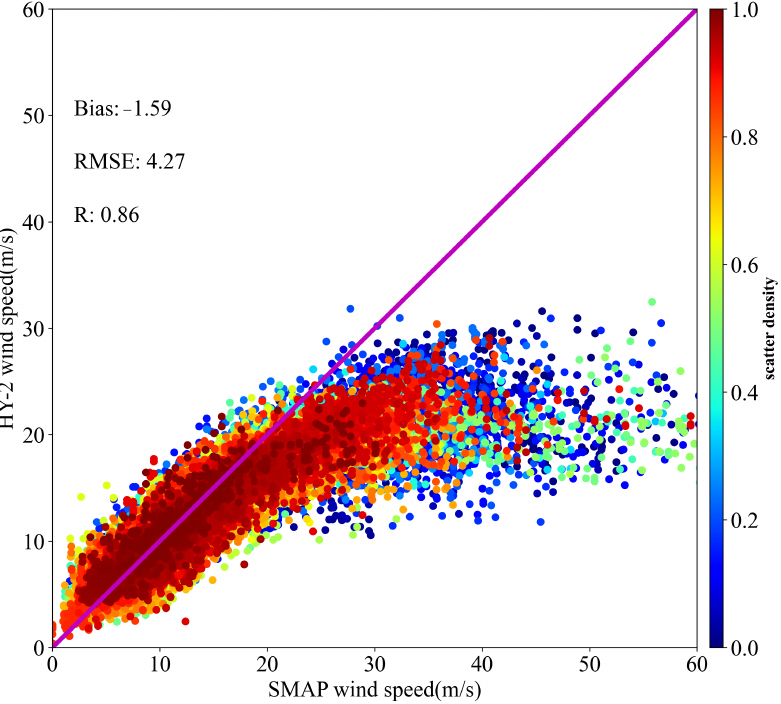
Figure 3. Two-dimensional scatter comparisons of high wind speed between HY-2B/C/D scatterom- eters and the SMAP radiometer from July 2019 to December